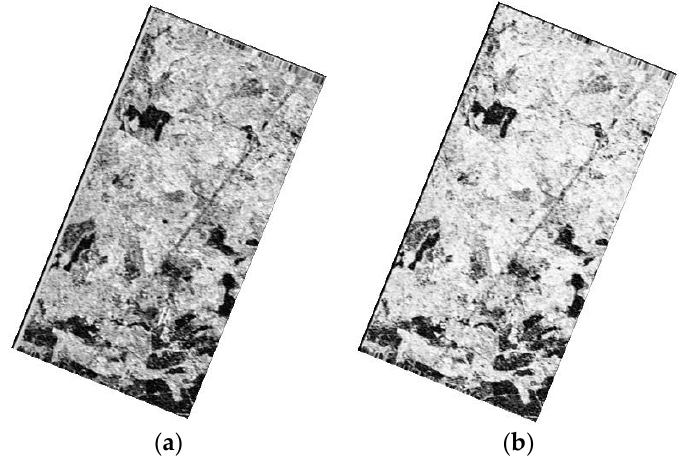
Figure 11. Height estimation of the proposed method on the BioSAR 2007 with P and L band for Remningstorp: ( a ) P band; and ( b ) L band.